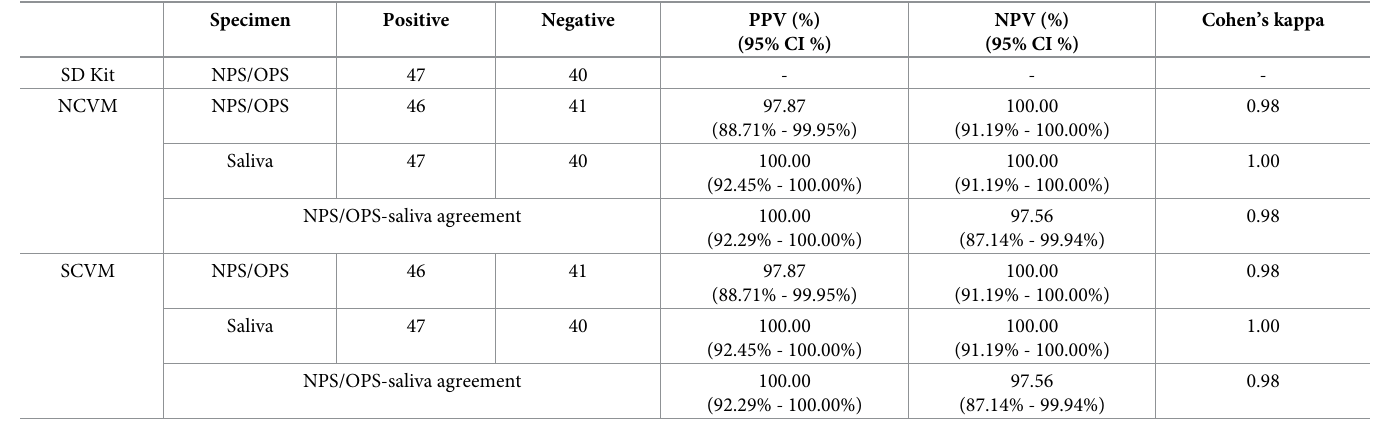
Table 7. Clinical performance evaluation results of the AccuPower 1 kits in saliva